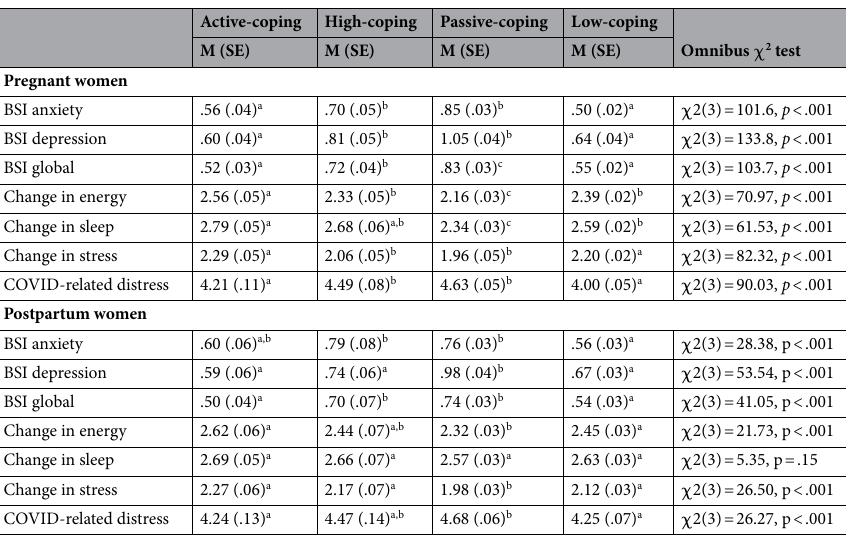
Table 3. Comparisons of mental and physical outcome measures between profiles for both pregnant and postpartum women. Superscripts indicate which groups differ based on significant ( a < .05) Wald tests, with Holm-Bonferroni corrections for multiple comparisons.